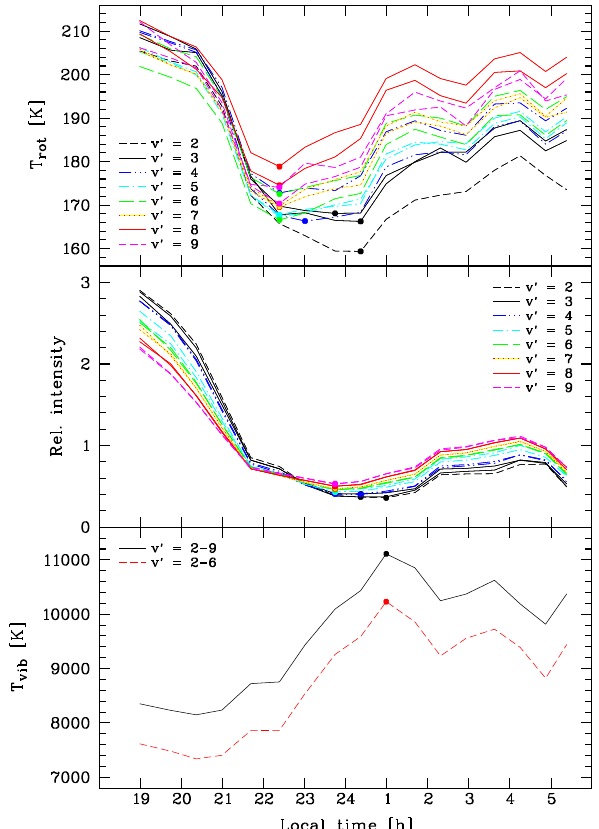
Figure 8. T rot , relative intensity, and T vib as a function of local time (UT corrected for geographical longitude) for a time series of 17 X-shooter observations taken during the night 29/30 July 2011. All data points are based on the G98 line parameters. The upper panel shows the line-set-corrected T rot for the OH bands (2-0), (3-0), (3- 1), (4-1), (4-2), (5-2), (5-3), (6-2), (6-3), (7-3), (7-4), (8-3), (8-5), (9-4), and (9-5). Bands with the same v (cid:48) are marked by lines of the same type and colour (see legend). The observation of each band with the lowest T rot is indicated by a filled circle. The middle panel shows the intensity of the same OH bands as listed above relative to the average for the 17 observations of the sample. The lowest intensity of each band is marked by a filled circle. The lower panel displays T vib derived from the lines of the bands listed above for two different v (cid:48) sets (2 to 9 and 2 to 6, see legend). The observations indicating the highest T vib are marked by filled